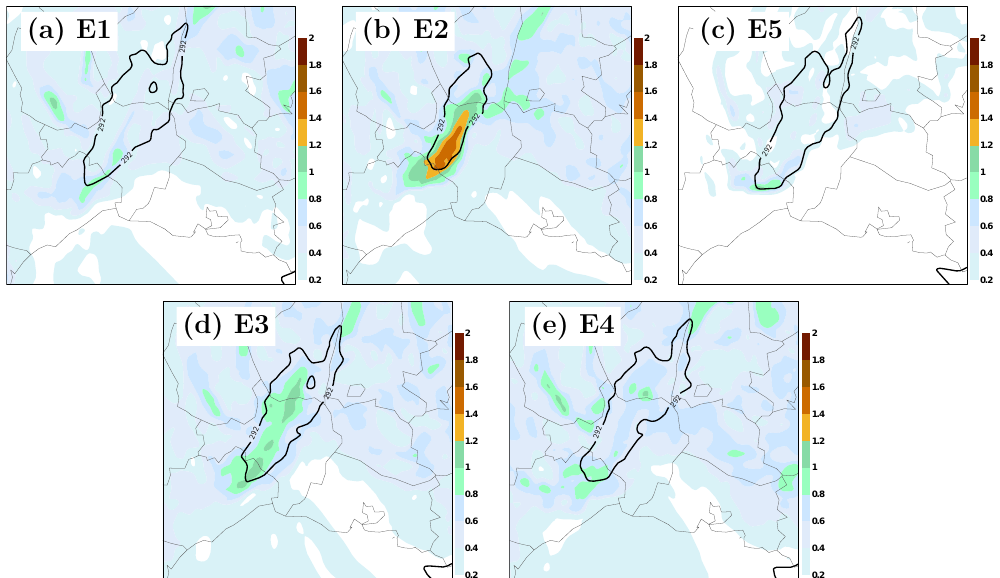
Fig. 10. Virtual potential temperature, ensemble spread (colour shading) and 292K contour of the ensemble mean (black), at 15:00 UTC 20 October 2008, for (a) E1, (b) E2, (c) E5, (d) E3 and (e) E4.